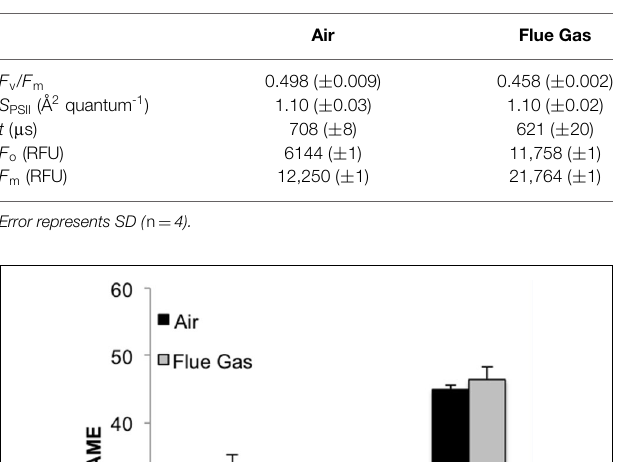
FIGURE 3 | Fatty acid methyl ester (FAME) profile for Heterosigma akashiwo bubbled with air (control) or simulated flue gas containing 12% CO 2 and 150ppm NO . ( A ) Individual FAMEs are reported as mean percent of total FAMEs ± SD ( n = 4). ( B ) Individual FAMEs are reported on a per cell basis as mean pg/cell ± SD ( n = 4).